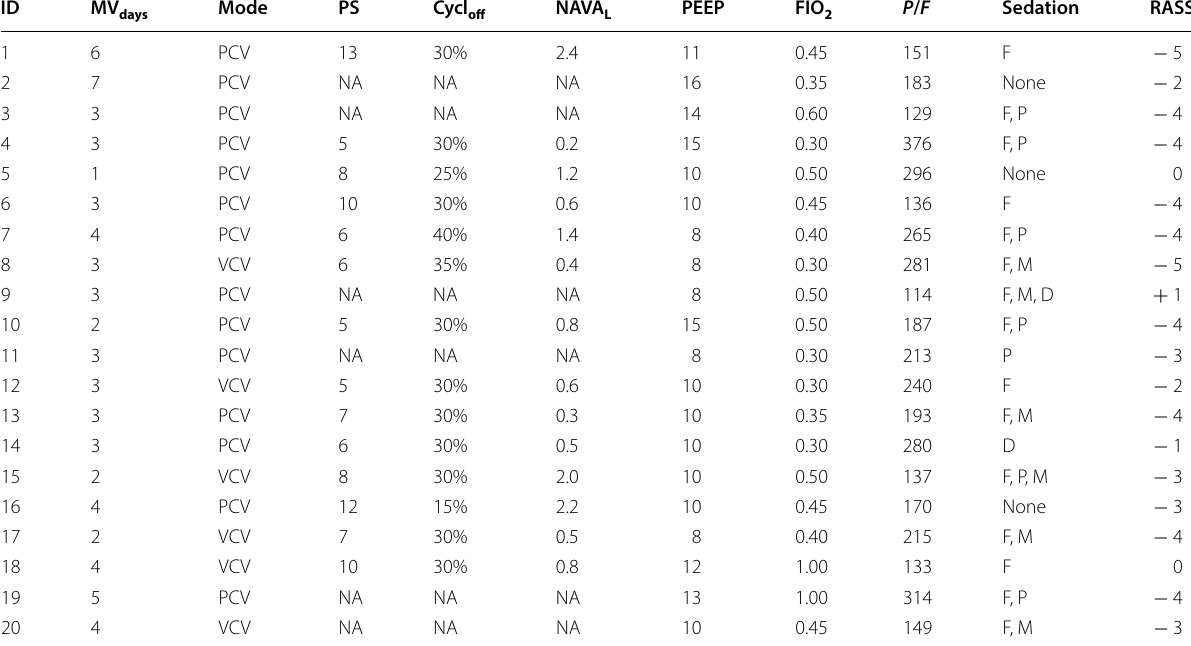
Table 2 Ventilator parameters and patient characteristics during the study